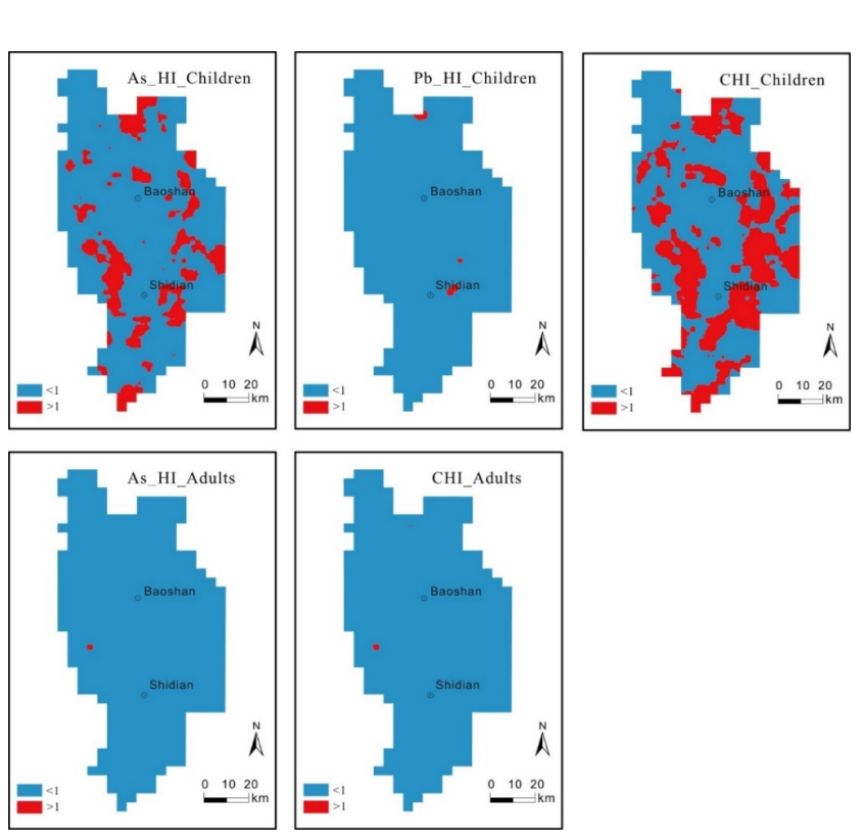
Figure 7. The distribution of counter maps of the non-carcinogenic risks (HI) and cumulative non- carcinogenic risk (CHI) determined by inverse distance-weighted (IDW)